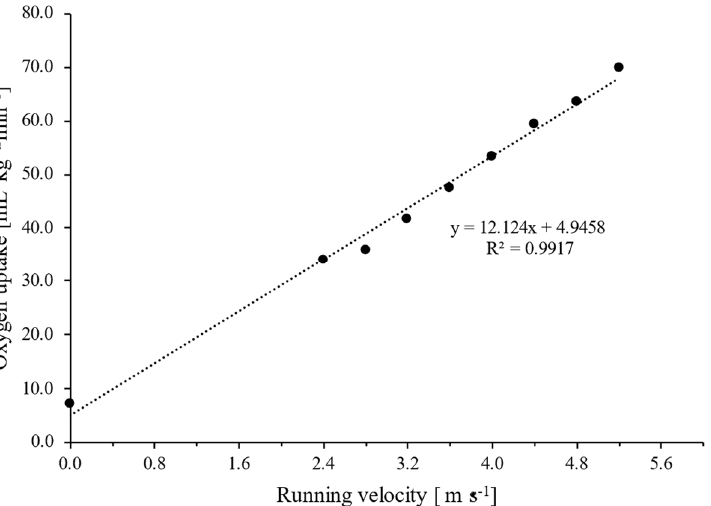
Figure 2. An exemplary description of the determination of the individual Ks 4 (constant value of the relationship between oxygen demand and running velocity). The slope of the regression line corresponds to Ks 4. From this equation, Ks 4 for this runner is 12.1 mL · kg − 1 · min − 1 per 1 m · s − 1 . After determining the individual Ks 4, the VO 2ss in relation to running velocity was calculated with Equation (2).